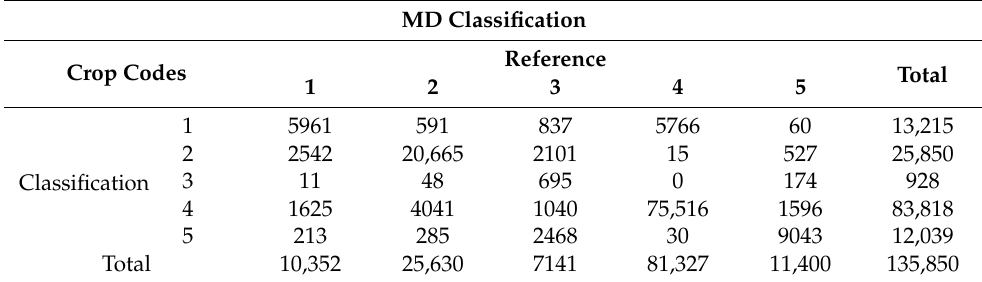
Table 10. Confusion matrix of AOI performed by MD